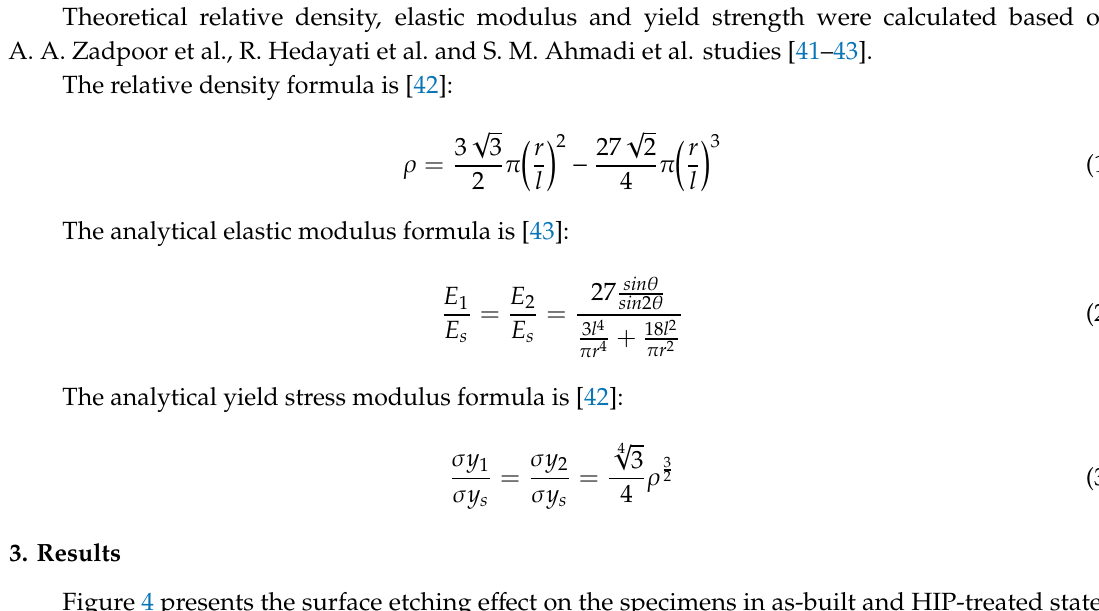
Figure 3. Elastic gradient calculation in accordance with the standard ISO 13,314. The compression stress–strain diagram with a marked elastic gradient tangent of ‘’ θ ’’. A 0.2% offset compressive proof stress is designated as “B” and maximum first stress is designated as “A” [37].